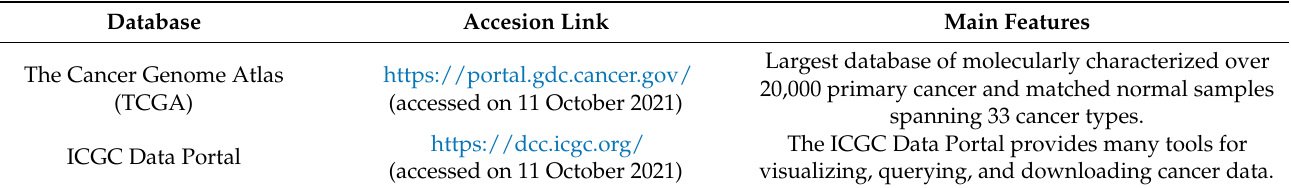
Table 1. Repositories of -Omics